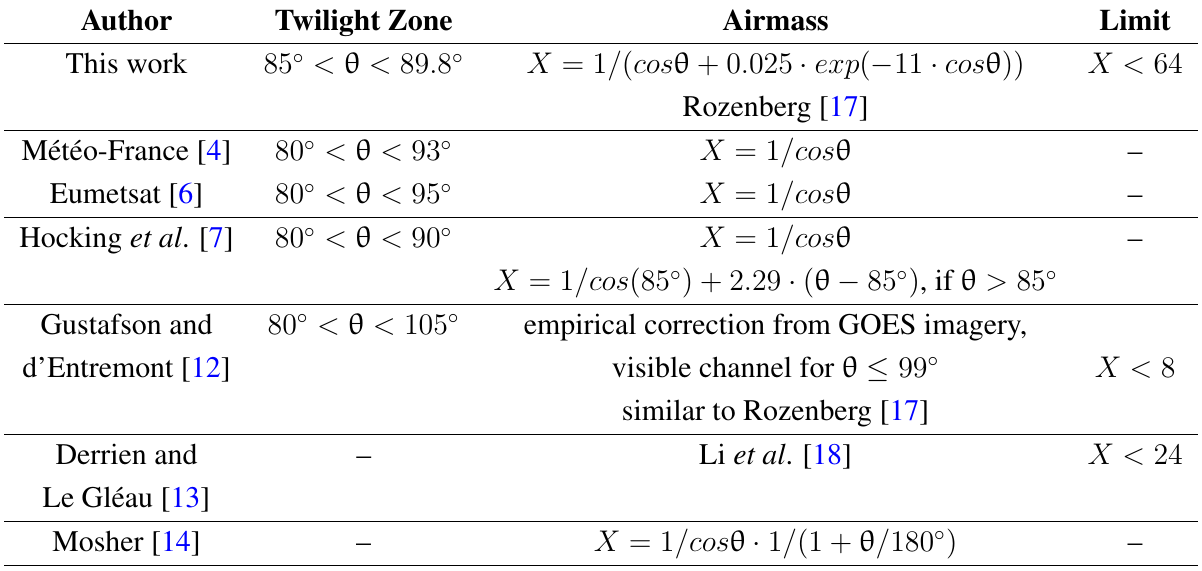
Table 1. Twilight zone and airmass definitions as given by different authors for Meteosat Second Generation (MSG) cloud detection. Here, θ denotes solar zenith angle in